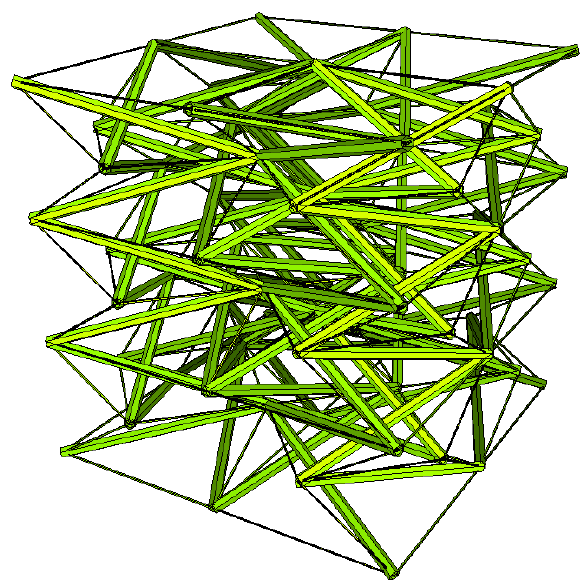
Figure 2. Tensegrity lattice with low modules (L).